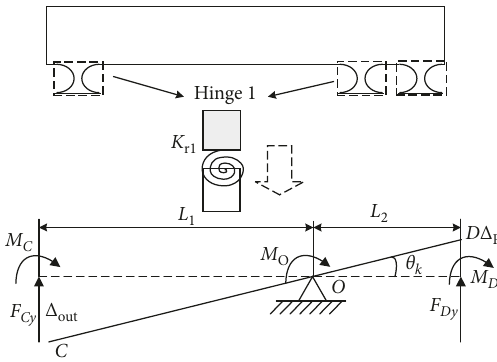
Figure 6: Mechanical model of the lever